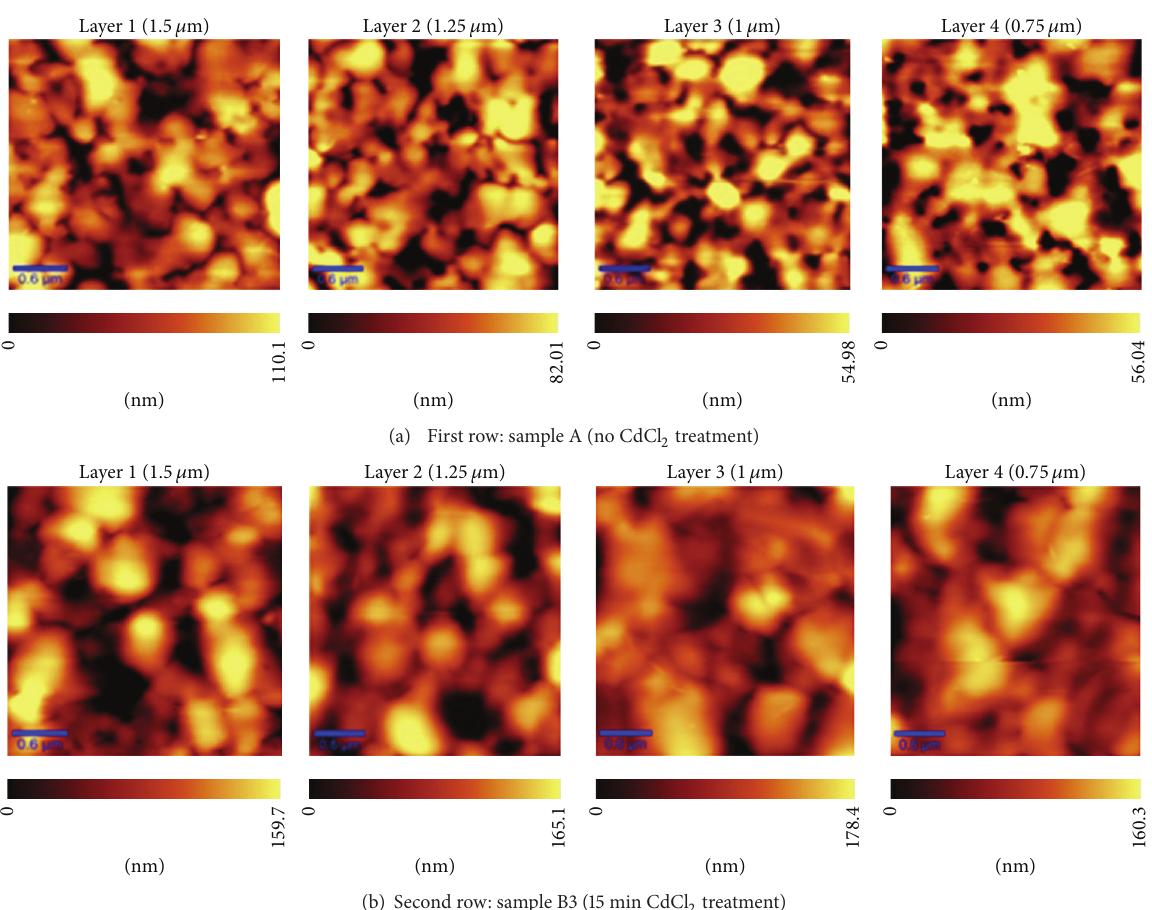
Figure 2: First row of AFM images is corresponding to sample A (No CdCl 2 annealing). The second row is corresponding to the sample B3 (with 15 min CdCl 2 annealing). The scale bar for all images is 0.6 𝜇